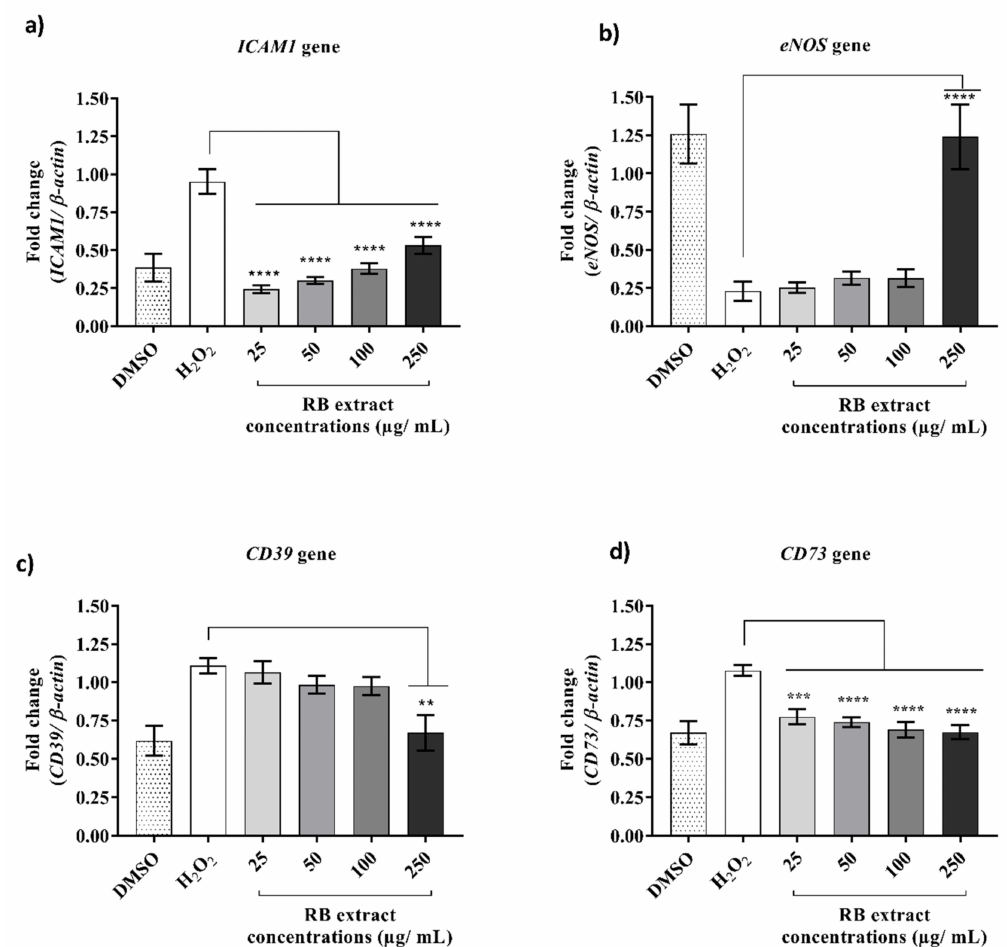
Figure 3. E ff ect of RB phenolic extracts on anti-inflammatory genes. ( a ) ICAM1 ( b ) eNOS ( c ) CD39 ( d ) CD73 in HUVECs under oxidative stress conditions. A significant reduction ( p < 0.0001) in the expression of ICAM1 and CD73 was seen across all RB phenolic treatments (25–250 µ g / mL). The expression of eNOS gene was significantly increased when pre-treated with 250 µ g / mL of RB phenolic extracts. In CD39 gene, a significant reduction ( p < 0.01) was observed at 250 µ g / mL RB concentration. The level of significance is indicated by the asterisks, whereby ** p < 0.01, *** p < 0.001, **** p < 0.0001. n = 3. Data is presented as mean ± SEM. Dimethyl sulfoxide, DMSO; hydrogen peroxide, H 2 O 2 ; human umbilical vein endothelial cells, HUVEC; rice bran, RB; intercellular adhesion molecule 1 ( ICAM1 ); endothelial nitric oxide synthase ( eNOS ); ectonucleoside triphosphate diphosphohydrolase 1 ( CD39 ); ecto-5 (cid:48) -nucleotidase ( CD73